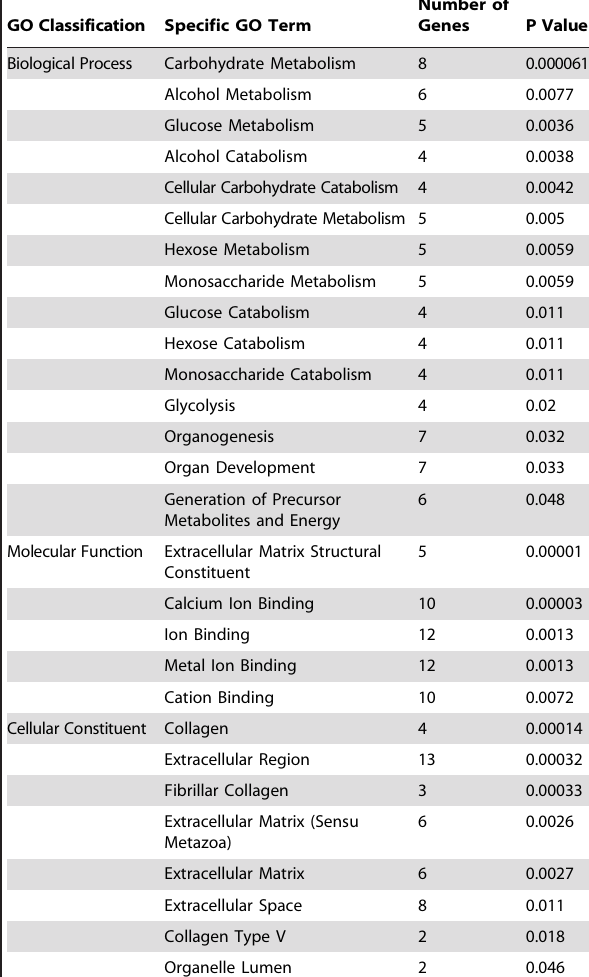
Table 4. Genes with $ 2-fold reduced expression in diabetic diaphragm assigned to over-represented gene ontology